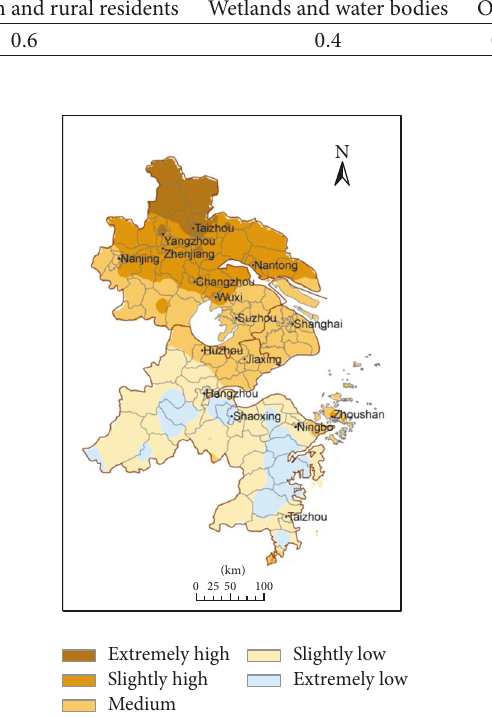
Figure 1: Distribution of drought hazard grades in the